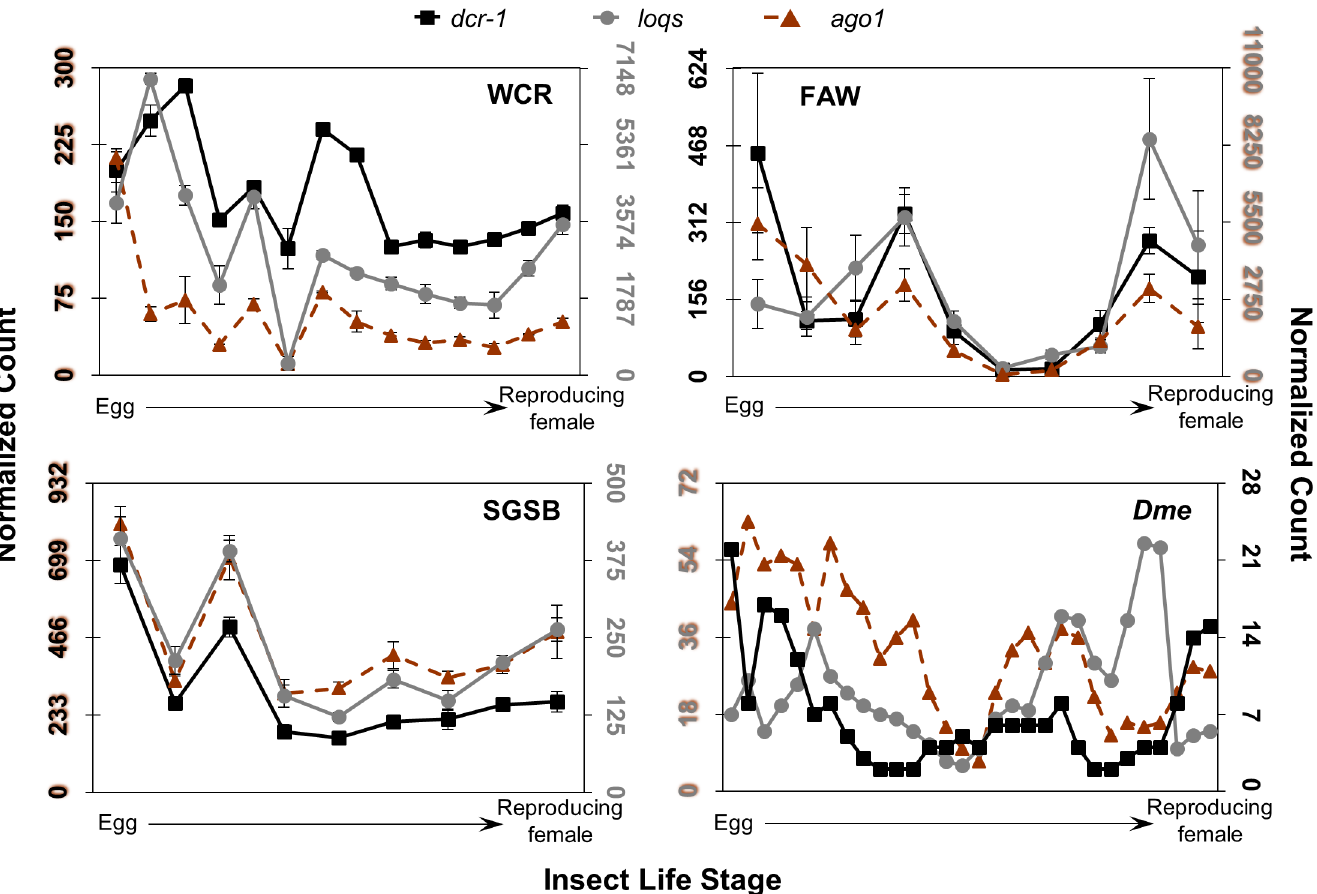
Fig 5. Expression patterns of core miRNA machinery across insect life stage. Normalized count data for each insect are plotted and resulting plots are positioned as in Fig 4. dcr-1 is shown in black squares, loqs in grey circles, and ago1 in orange triangles with dotted line. The WCR graph scales loqs-RB on the left axis, and dcr-1 and ago1-RC on the right. The FAW graph scales loqs-RBb and ago1-RCa on the left axis, and dcr-1 on the right; axes colors also reflect gene target scaling. The SGSB graph shows loqs-RB and ago1-RC isoforms. The Dme graph scales loqs and ago1 on the left axis, and dcr-1 on the right; specific isoforms are unknown.